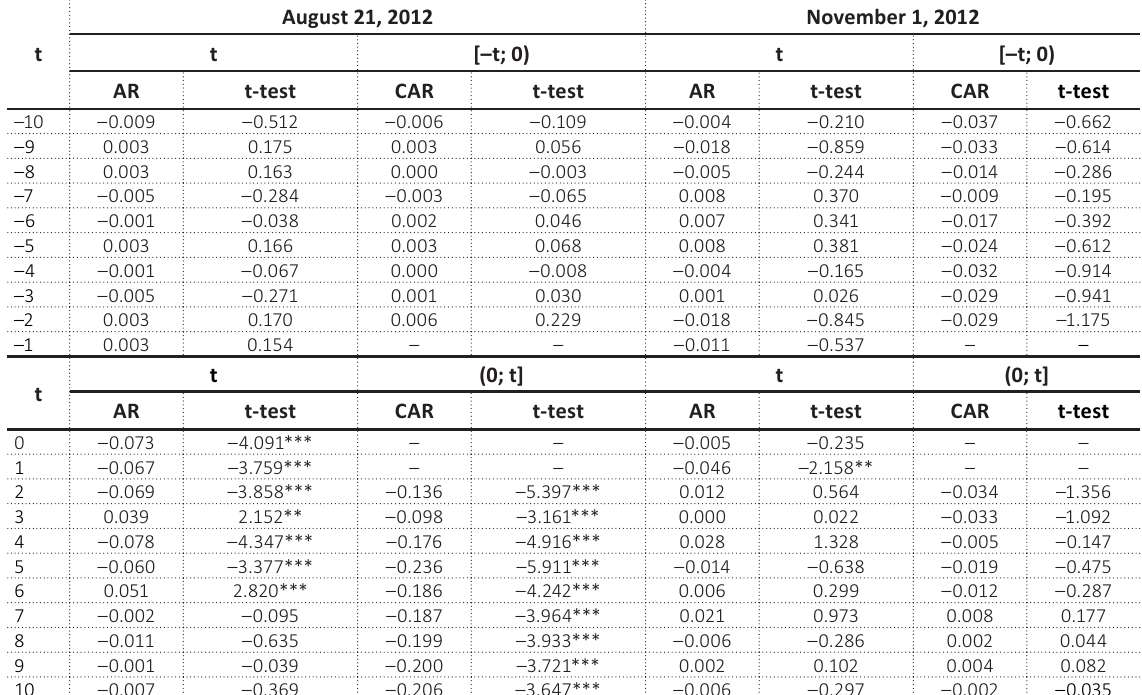
Table 1. Results of abnormal returns and cumulative abnormal returns of ACB